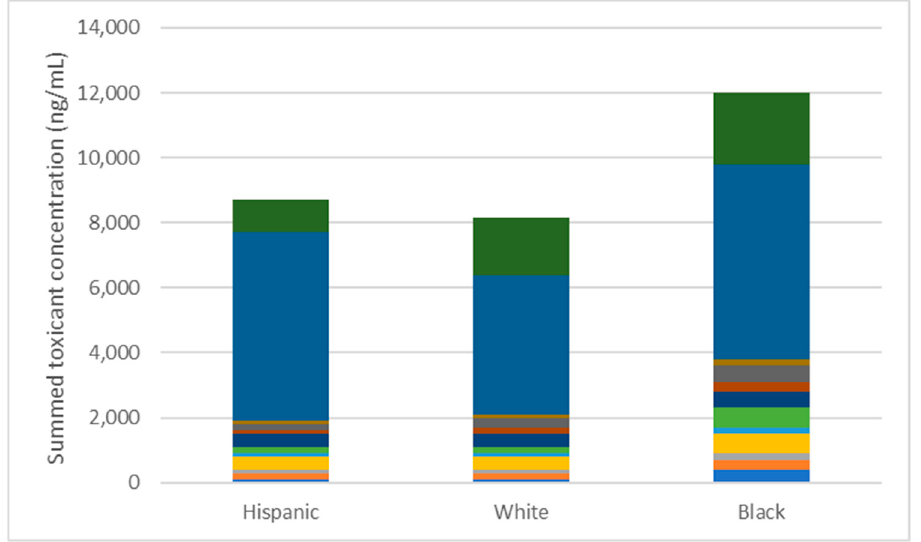
Figure 1. Summed body burden of 59 chemicals in the National Health and Nutrition Examination Survey 2008–2009 dataset stratified by race/ethnicity demonstrate that non-Hispanic Blacks have higher total chemical burden. About 80% of the chemicals evaluated were higher in non-Hispanic Blacks than other racial/ethnic groups.